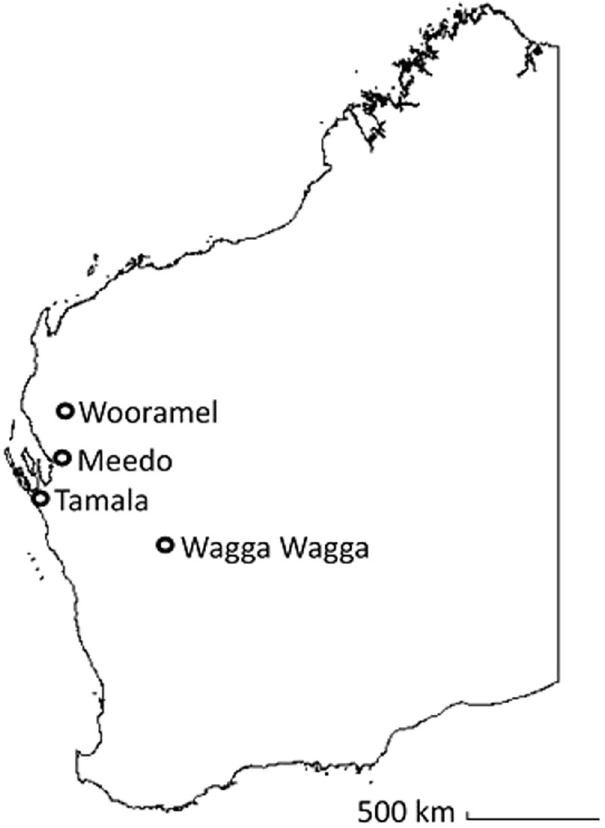
Figure 1. Map depicting locations of the stations from which goat consignments were